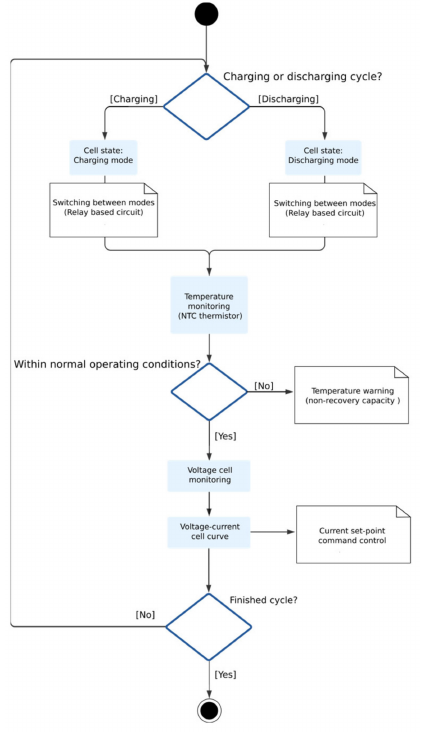
Figure 4. Cell control flow